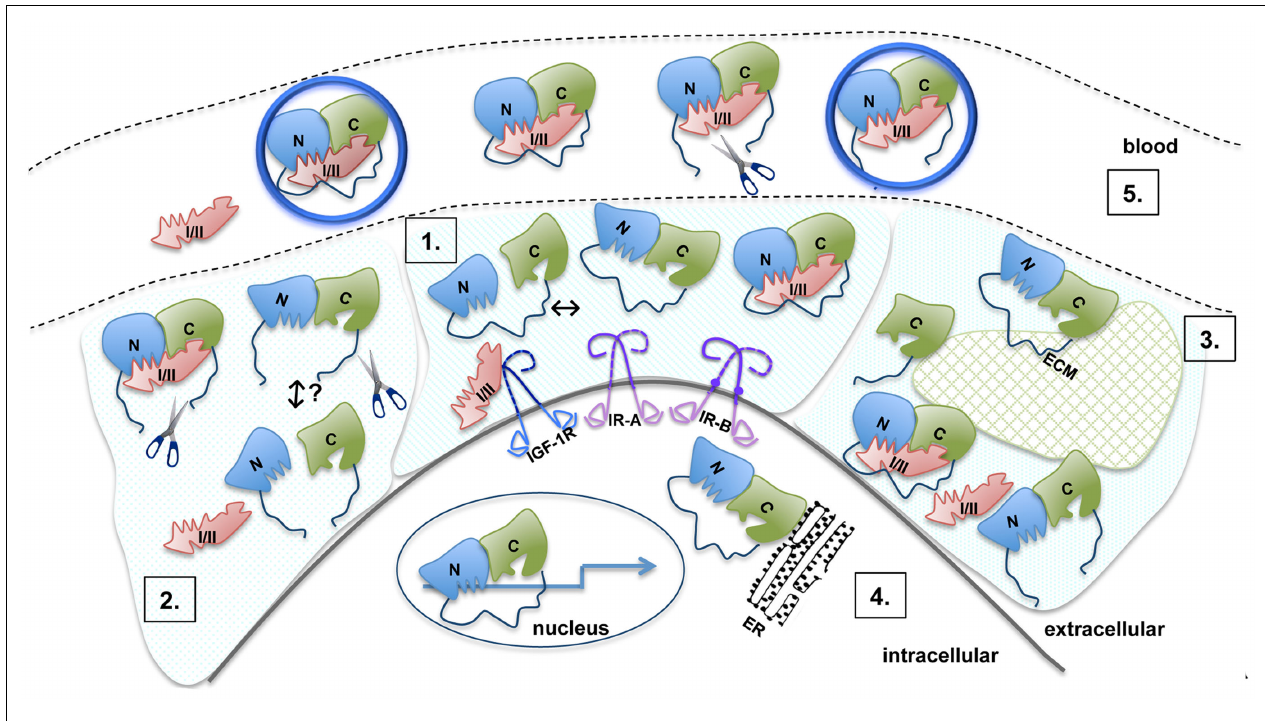
associated via the inter-domain interface. Cleavage products are susceptible to further breakdown, which possibly leads to the equilibrium being pushed toward free IGF and individual IGFBP domains. 3. Intact and cleaved IGFBPs bind extracellular matrix components (ECM, glycosaminoglycans, and proteins) via the C-domain (and the linker domain in IGFBP-2). Binding to ECM (hatched green shape) lowers the affinity for IGFs. 4. IGFBP-2, -3, -5, and -6 are found within the nucleus and can affect gene expression (arrow). IGFBP-3 can be associated with the endoplasmic reticulum (ER). 5. Binary IGFBP:IGF complexes, intact IGFBPs, and cleavage products can be found in the blood. IGFBP-3 and -5 form a trimeric 150kDa complex with IGF and the acid labile subunit (ALS, large blue circle). Even with limited proteolysis in the L-domain, IGFBP fragments can also form a trimeric complex. Only the binary complexes are small enough to cross the vascular epithelium into the extracellular space to promote IGF-dependent biological